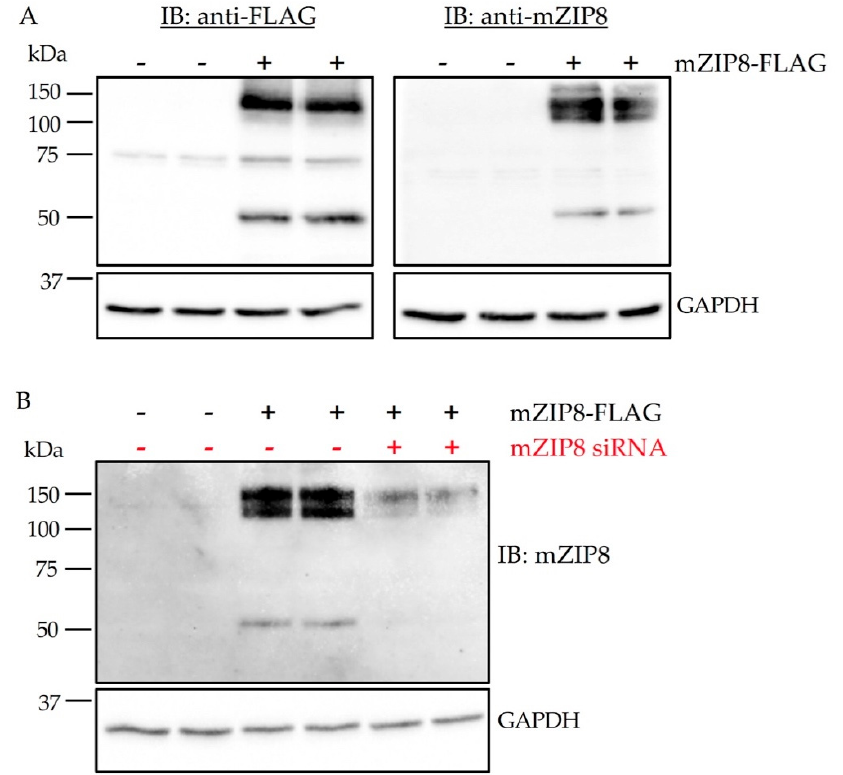
Figure 5. Validation of the anti-mZIP8 antibody in HEK293 cells. ( A ) Affinity-purified anti-mZIP8 antibody was validated in HEK293 cells overexpressing FLAG-tagged mZIP8 (+). Fourty-eight hours after transfection with plasmid encoding mZIP8, HEK293 cells were lysed and analyzed by immunoblotting (IB) with anti-FLAG or anti-mZIP8 antibodies. ( B ) HEK293 cells were transfected with the control vector (-) or a vector expressing FLAG-tagged mZIP8 (+). Twenty-four hours later, cells were transfected with negative control siRNA (-) or ZIP8-targeting siRNA (+). siRNA-mediated knockdown confirmed the identity of mZIP8 protein. The siRNA transfection was carried out for 24 h prior to immunoblotting analysis. GAPDH was used as the loading control.